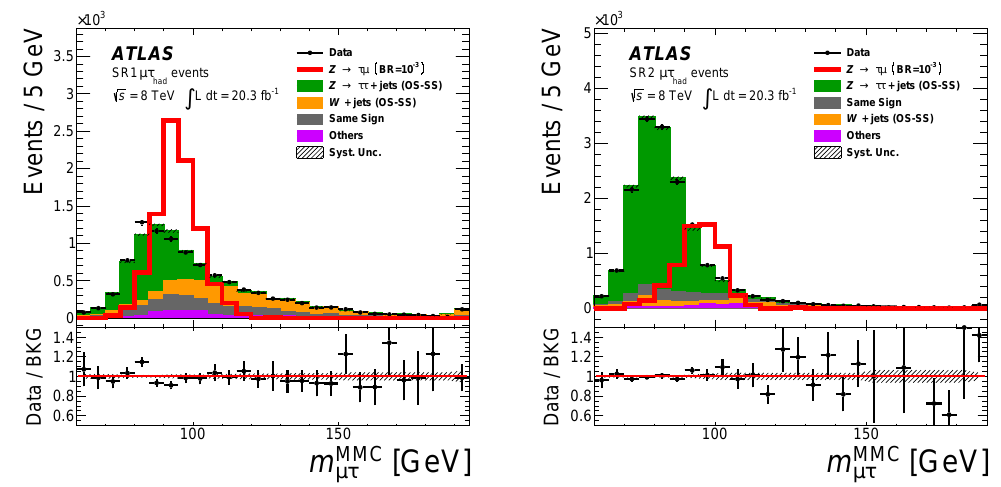
Figure 4: The distribution of the reconstructed di-tau mass in the search for Z → µτ for the two signal regions which suppress the SM Z → ττ (left) and W + jets (right) backgrounds respectively [ 11 ] . The lower panels quantify the agreement between background model and